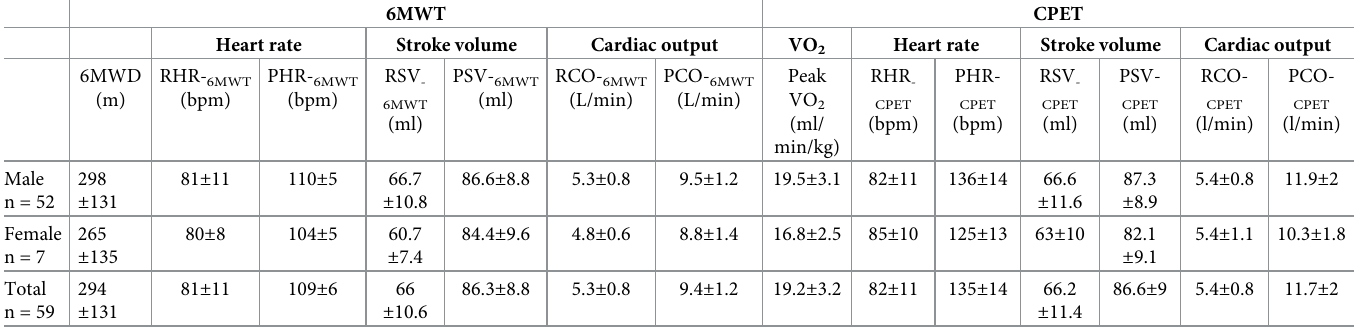
Table 2. Cardiodynamic parameters measured by ICG at end of 6MWT and CPET. Data in mean ± SD.